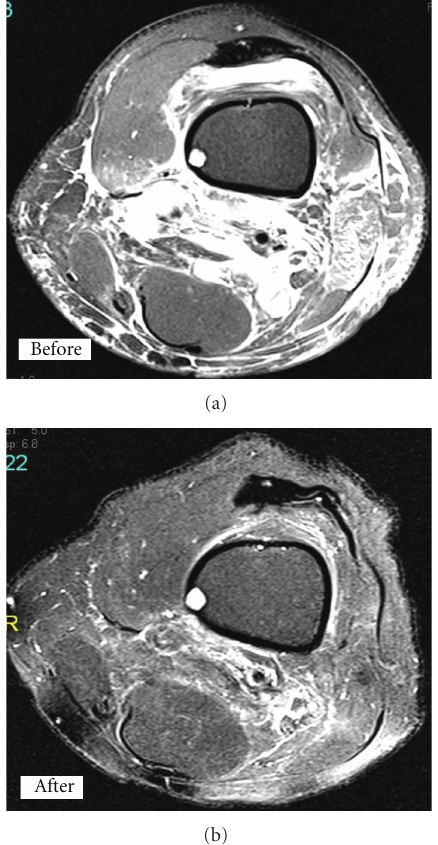
Figure 1: MRI of the Knee showing proximally dissecting ruptured baker cyst before and after